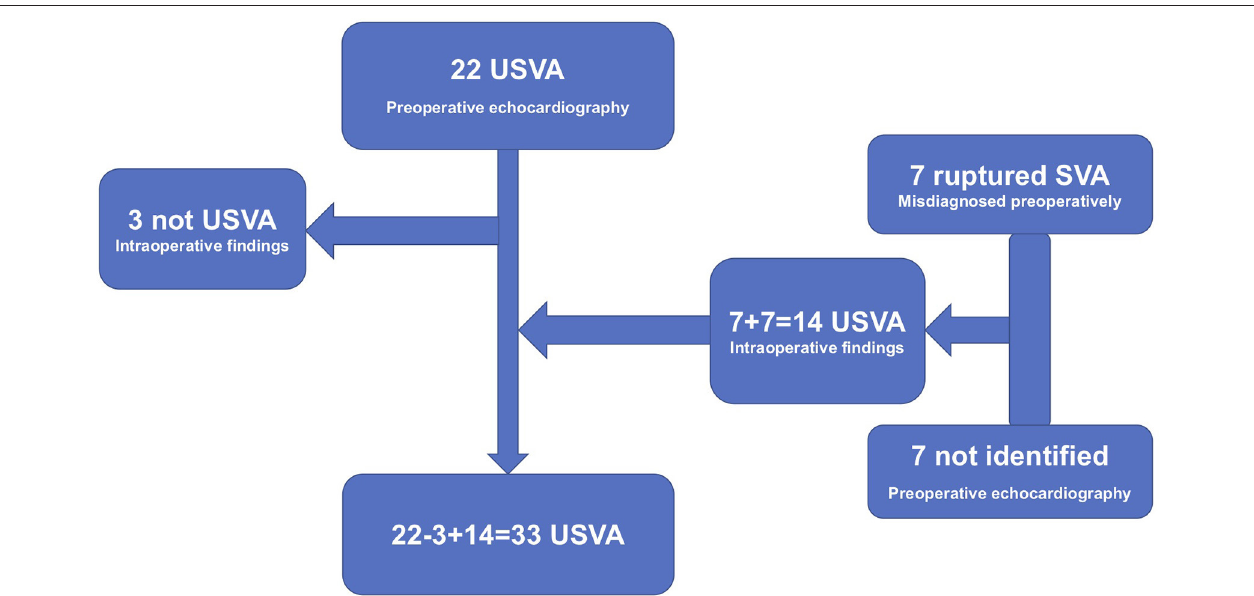
FIGURE 1 | Twenty-two patients were diagnosed with a USVA using preoperative echocardiography. Three patients’ diagnoses were revised during the operation. The other 14 USVAs were diagnosed during the operation. Among these 14 patients, seven were misdiagnosed as having a ruptured SVA by preoperatively echocardiography. Another seven patients had lesions that were not identified by preoperatively echocardiography. Thus, the accuracy of preoperative echocardiography was ∼ 52.8% (19/36).